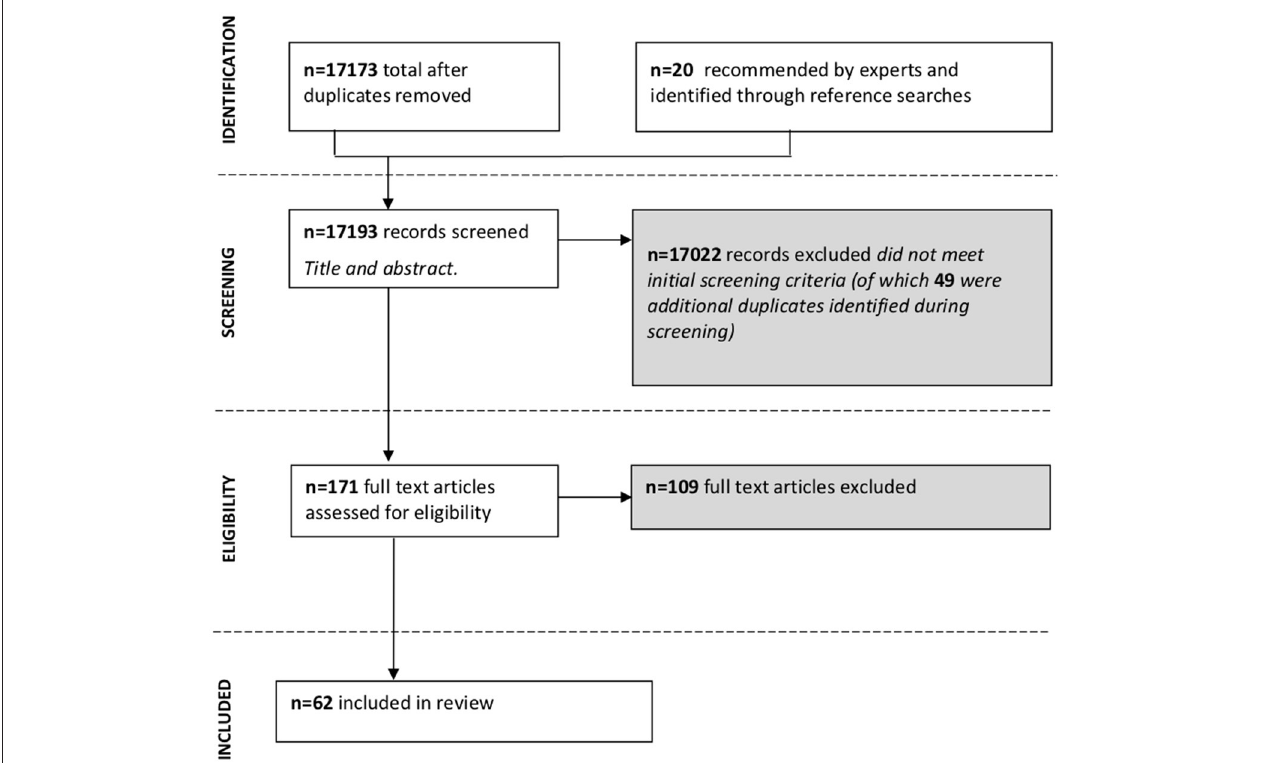
FIGURE 1 | Preferred Reporting Items for Systematic Reviews and Meta-Analyses (PRISMA) flow diagram of the screening and selection process conducted in this systematic review. (10%) of these papers focused on a low-income sample. In